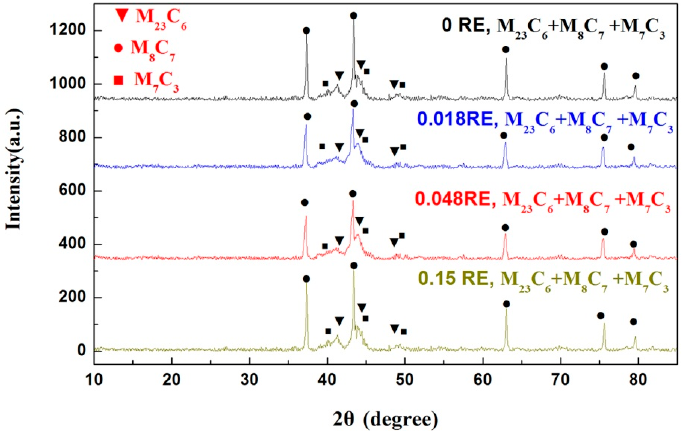
Figure 6. X-ray diffraction patterns of the 4Cr5MoSiV1-RE die steel with different additions of RE. Table 2. Phase composition, space group and lattice parameters of carbides of the 4Cr5MoSiV1- x RE ( x = 0, 0.018, 0.048, 0.15) steels determined by the analysis of XRD data.